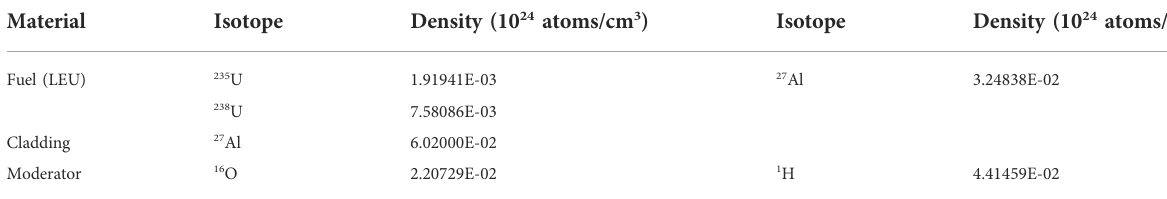
TABLE 5 Material compositions for MTR fuel assembly.